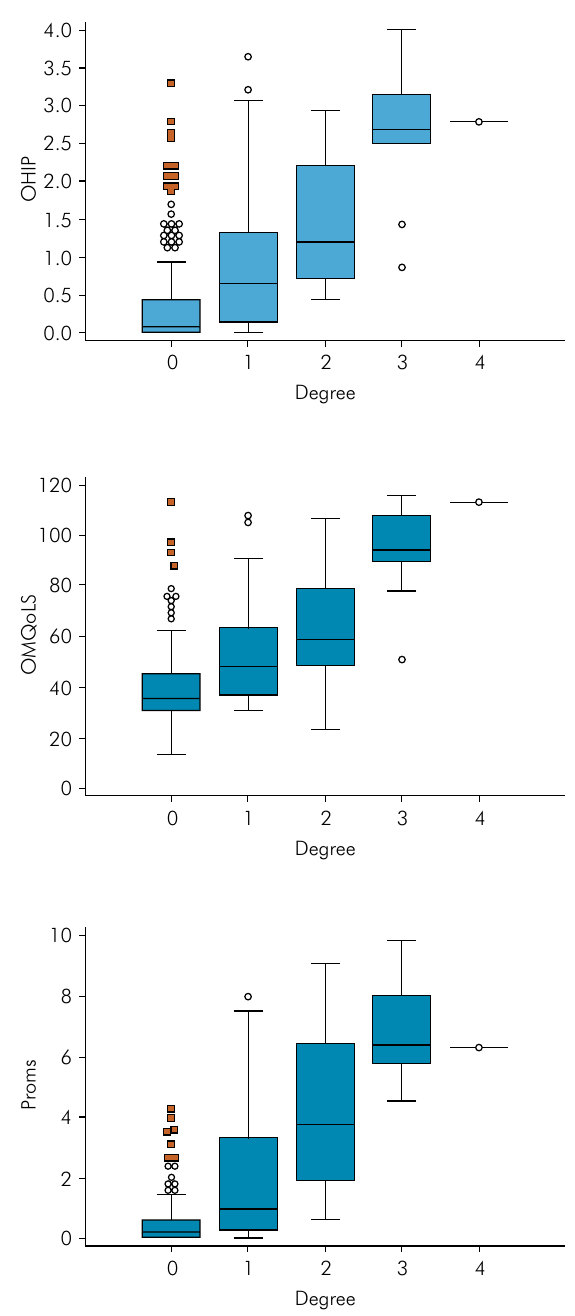
Figure 1. Mucositis and quality of life instrument correlations. 1A- Mucositis and OHIP-14. 1B- Mucositis and OMQoL. 1C- Mucositis and PROMS